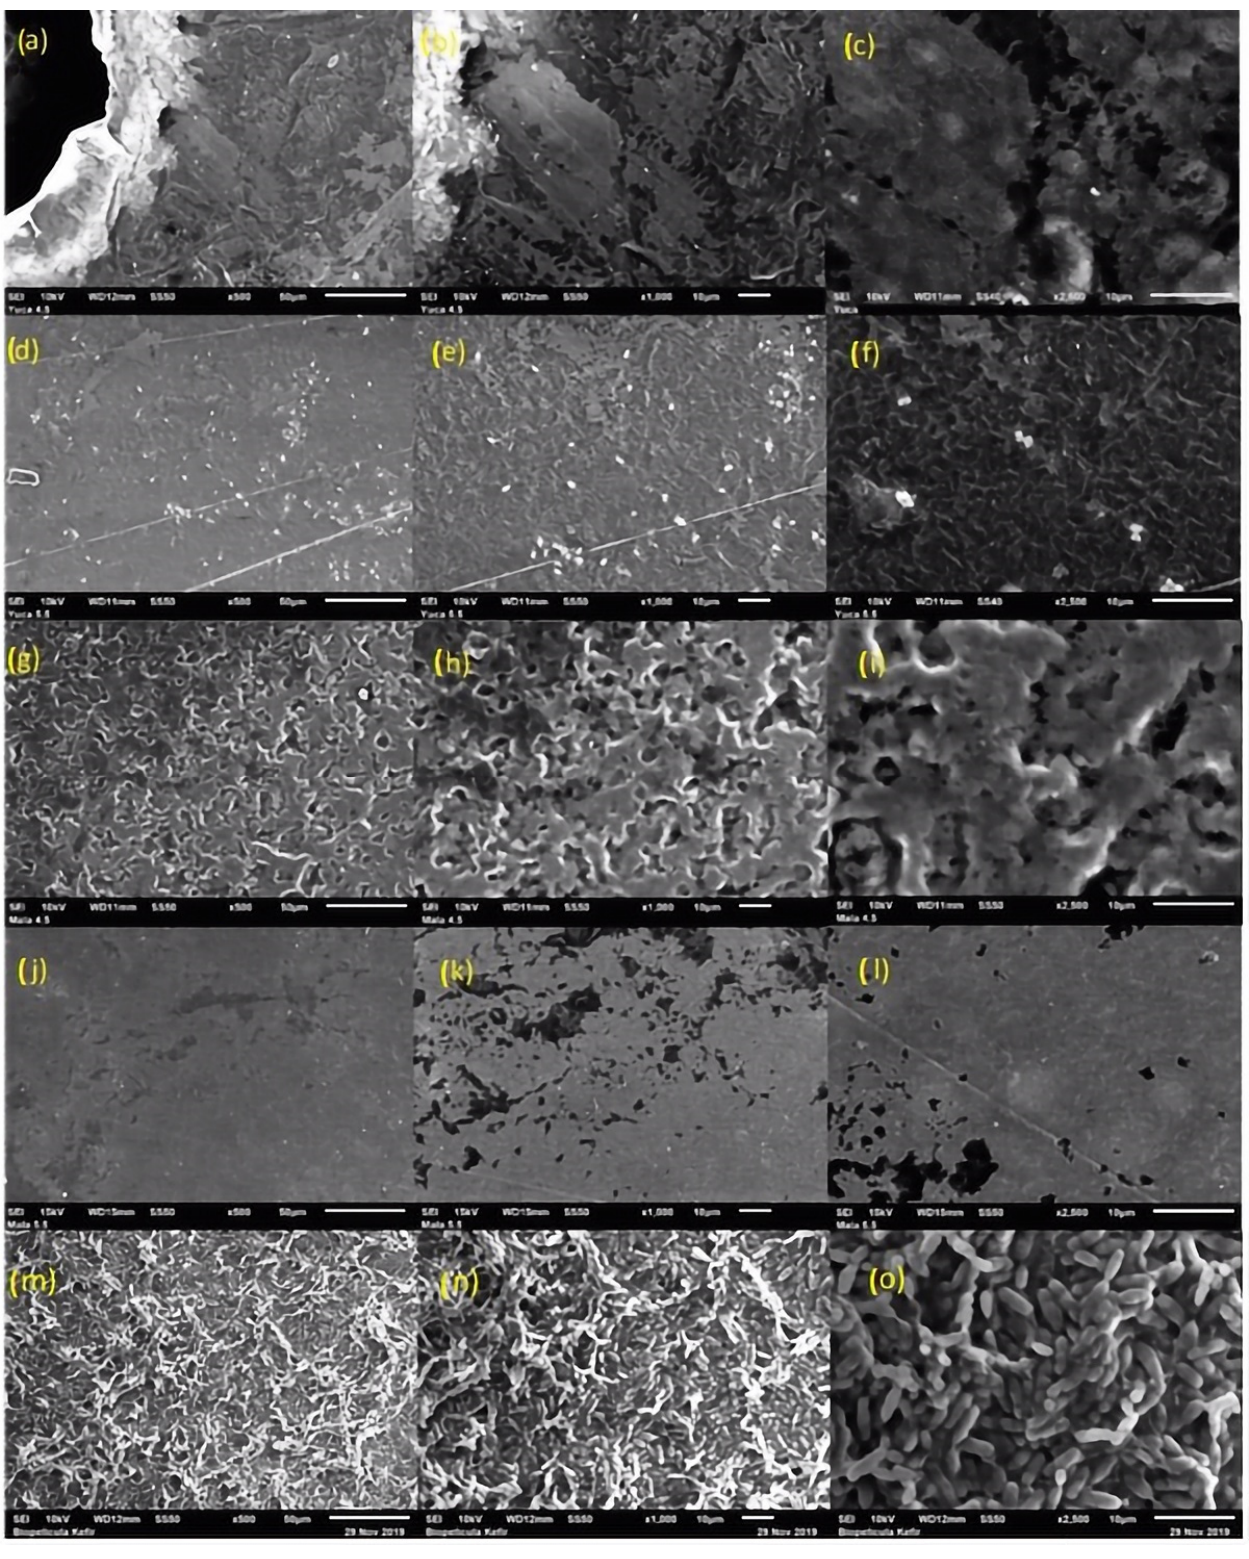
Figure 8. SEM micrograph (500, 1000, 2500×) respectively of edible films cryofracture: ( a – c ) cassava at 4.5 g of starch, ( d – f ) cassava at 5.5 g of starch, ( g – i ) taro at 4.5 g of starch, ( j – l ) taro at 5.5 g of starch, ( m ) biofilm of water kefir grains to 500×, ( n ) biofilm of water kefir grains to 1000×, ( o ) biofilm of water kefir grains to 2500×.